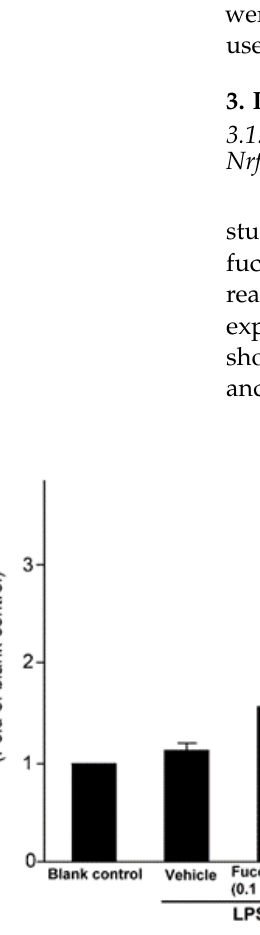
Figure 1. Effect of fucoxanthin on Nrf-2. Cytosolic ( A ) or nuclear proteins ( B ) were determined by ELISA and are expressed as the relative level of the controls. The experiments were repeated three times and similar results were obtained. The results are presented as the mean ± SD ( n = 5). * p < 0.05: Significant difference compared to the blank control group (Student’s t -test); # p < 0.05 and ## p < 0.01: Significant difference in the LPS-treated groups (one-way ANOVA followed by Bonferroni’s multiple comparison test).